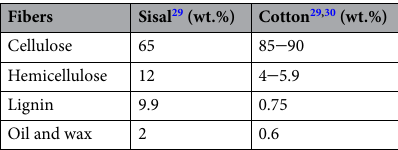
Table 1. Chemical properties of sisal and